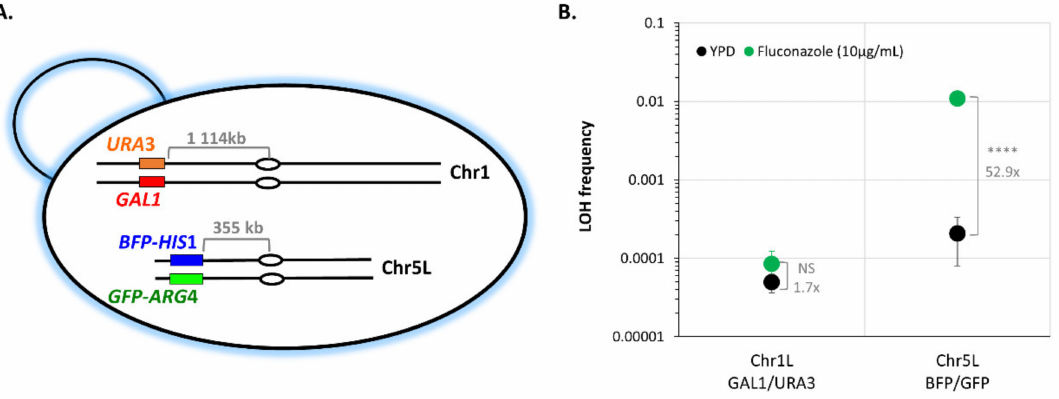
Figure 8. Assessing LOH frequency of two distinct C. albicans chromosomes within a single strain. ( A ) Illustration of the strain possessing the BFP/GFP LOH reporter system on Chr5L and the GAL1/URA3 system of Chr1L. Centromeres are indicated by ovals and distances between reporter systems and centromeres are indicated in gray. ( B ) Median frequencies of mono-fluorescence, LOH frequency, in YPD (black), and 10 µ g/mL fluconazole (green), +/ − standard deviation. LOH frequen- cies were assessed by fluctuation analysis (two independent strains, n = 6). Fold changes of median LOH frequencies, between YPD and fluconazole conditions are indicated on the plot in gray and statistical differences were evaluated using t -test (NS p > 0.05 and **** p <